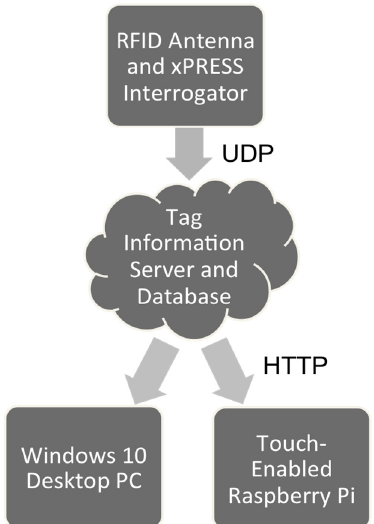
Figure 5. High-level system topology showing network communication protocols used between Figure 5. High ‐ level system topology showing network communication protocols used between system system modules.